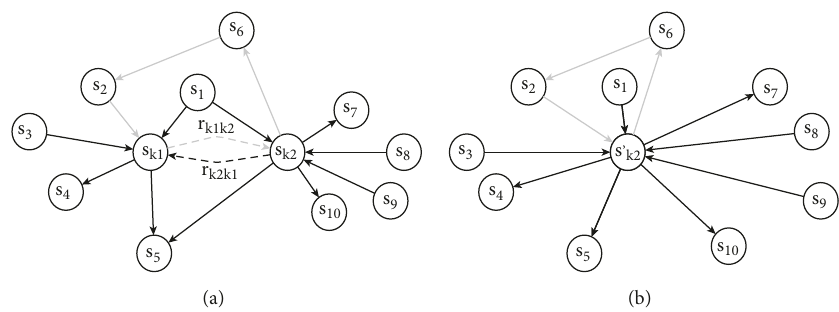
Figure 3: Graphical explanation of how the reaction network structure of N 󸀠 in the proof of Proposition 15 is constructed. (a) Reaction network structure of an 𝑛 -dimensional d-CRN N . (b) Reaction network structure of N 󸀠 resulting from merging the species 𝑠 𝑘 along their shared reaction 𝑟 𝑘 Γ 󸀠 having redundant reactions (e.g., (𝑠 are omitted in (b). A directed cycle on which the chosen reaction 𝑟 𝑘